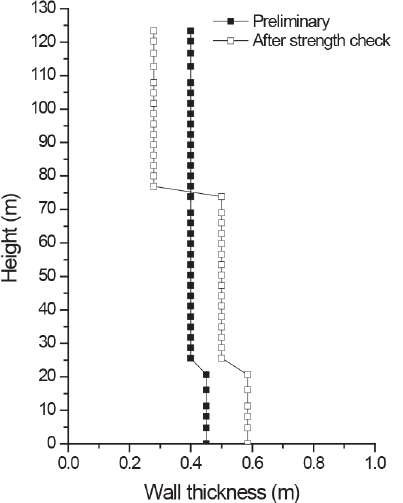
Fig. 6. Changes in the wall